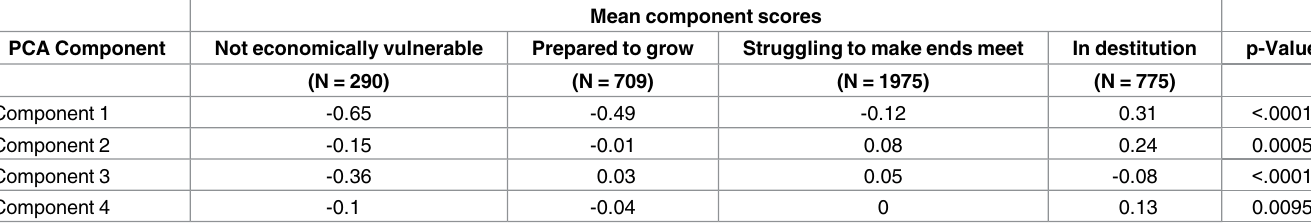
Table 3. Comparison of component scores with data collectors’